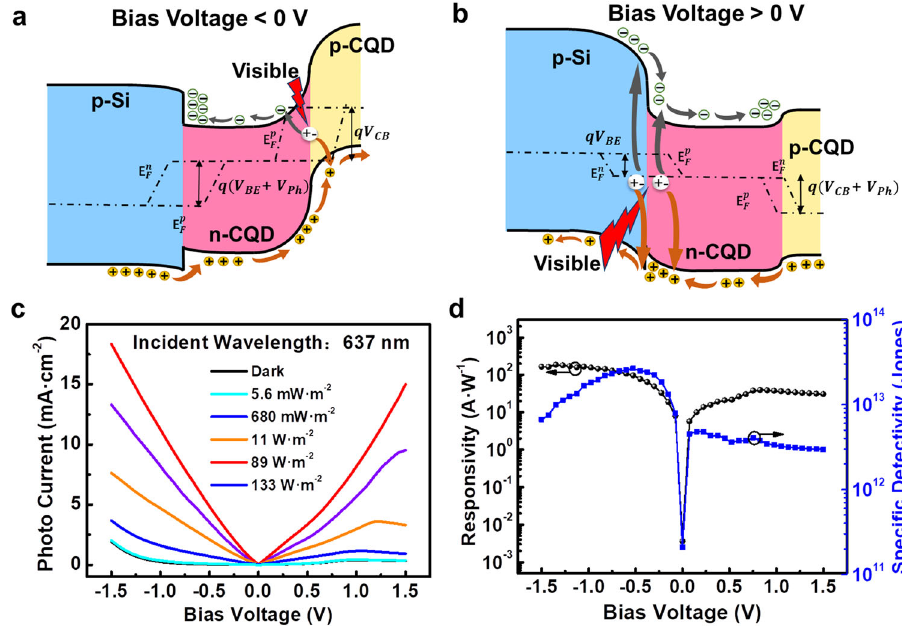
Fig. 4 Operation of the PVTRI with visible excitation. Energy bands and operation mechanism of the PVTRI with a negative bias and b positive bias voltages in the visible excitation. c Output characteristics of the PVTRI with different incident powers under illumination of 637 nm. d The responsivity and speci fi c detectivity of the PVTRI as a function of bias voltages at a low incident power of 5.6 mW m − 2